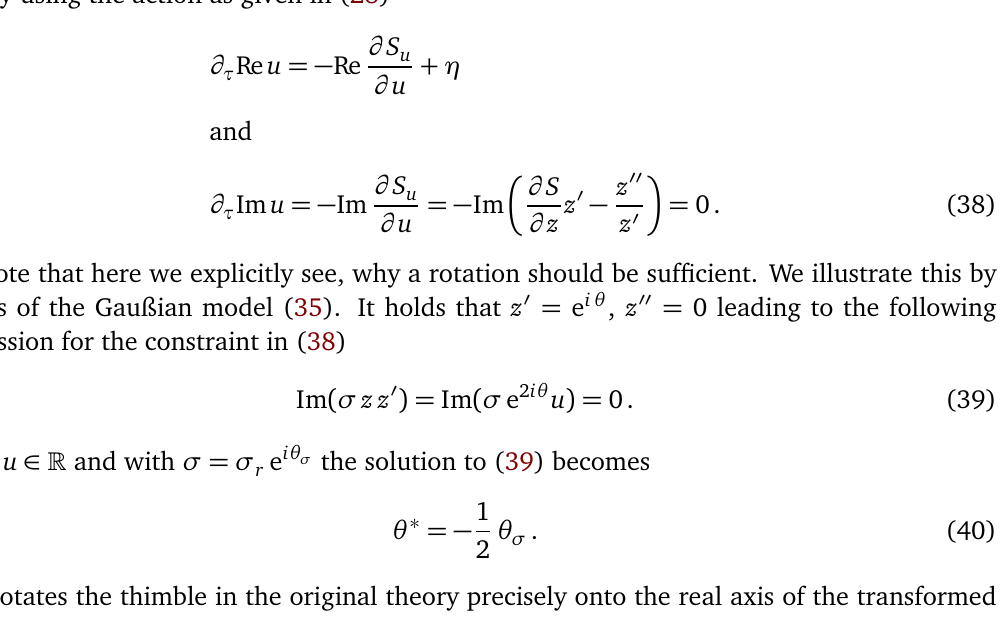
] = const, while the black z ] = u